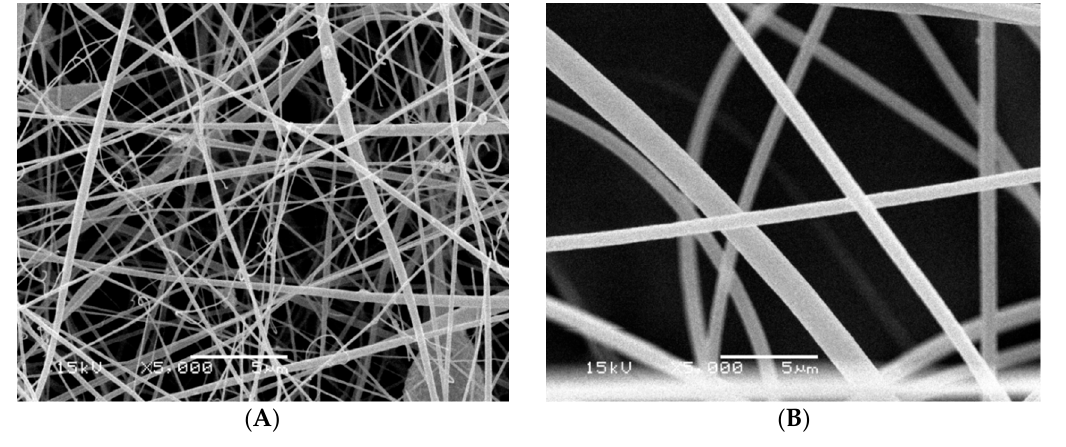
Figure 3. SEM micrographs of ( A ) poly(AN- co -ST) nanofibers; and ( B ) modified poly(AN- co -ST) nanofibers.